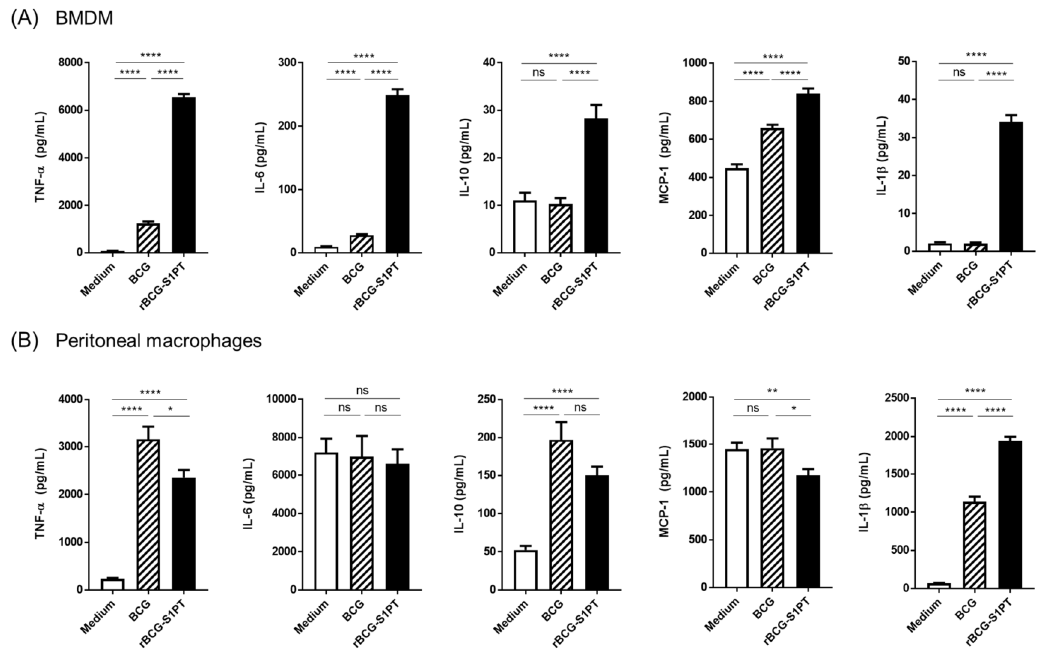
Figure 2. Primary response of BMDM ( A ) and peritoneal macrophages ( B ) to wild-type BCG or rBCG-S1PT. Bone marrow-derived macrophages and peritoneal macrophages recovered from naïve mice were exposed in vitro to culture medium alone (medium), BCG, or rBCG-S1PT (MOI 0.1:1) for 24 h. The production of TNF- α , IL-6, IL-10, MCP-1, and IL-1 β (panels from the left to right) was measured in the 24 h supernatants. Statistical significance was assessed via Mann–Whitney U test. * p < 0.05, ** p <0.01, **** p <0.0001, ns = not significant. Bars represent mean ± SEM of 10